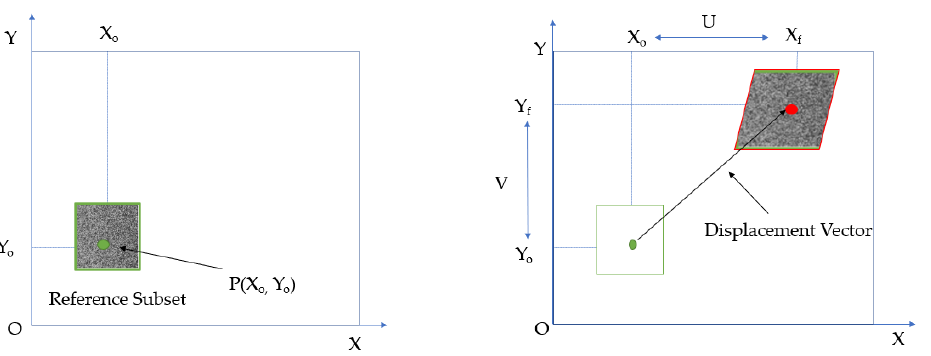
Figure 1. Temporal matching for the correlation function generation of unreformed and deformed